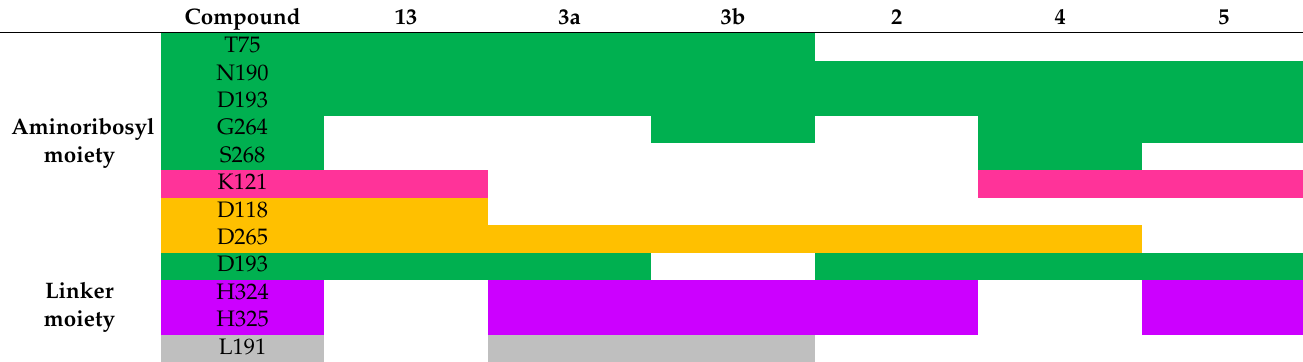
Table 3. MraY AA binding site hotspots (PDB: 5CKR) for the aminoribosyl and linker moieties of hits.